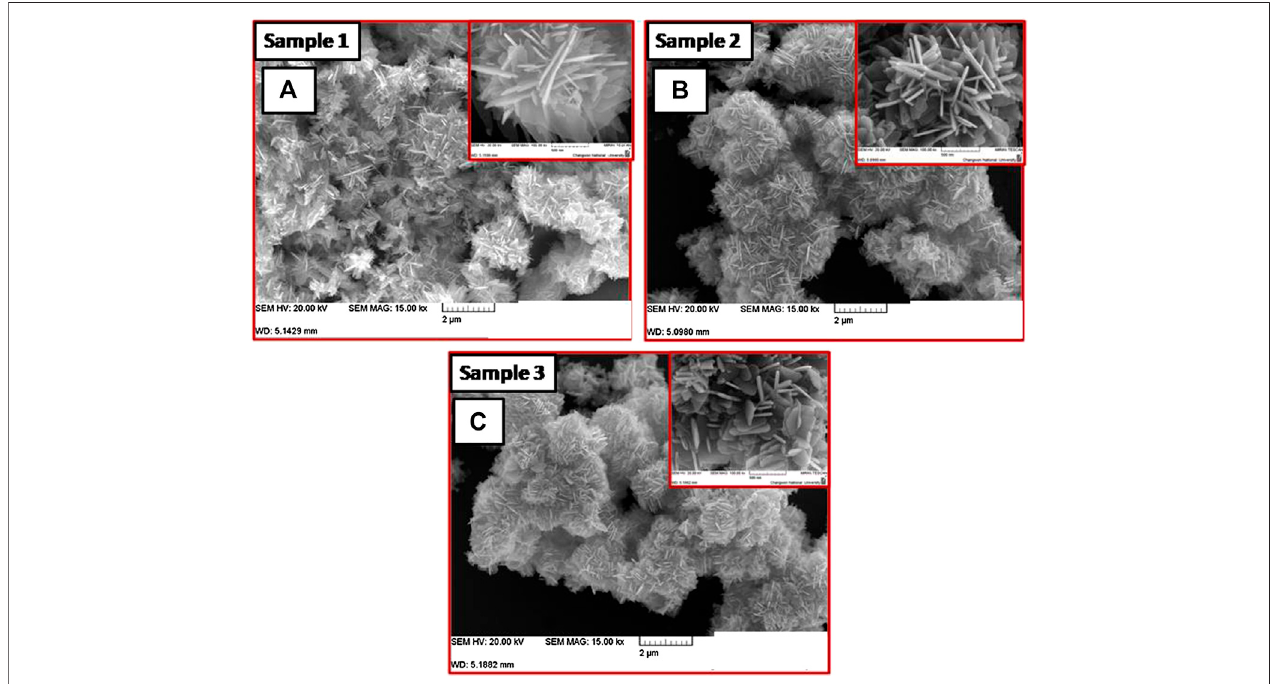
FIGURE 2 | FESEM images of ZnO nanosheets for (A) sample 1 (1:2.5) (B) sample 2 (1:2.75), and (C) sample 3 (1:5).